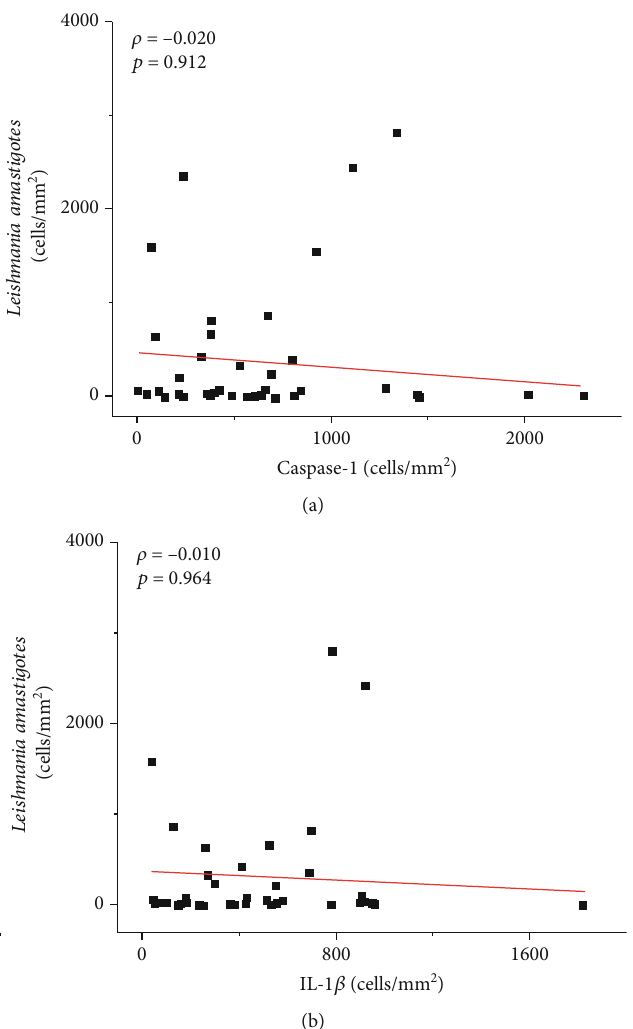
Figure 7: Graphs showing the correlation between the density of Leishmania amastigotes and caspase-1 + cells (a) and IL-1 β + cells (b). The value of ρ is Spearman ’ s correlation coe ffi cient, and p is the p value. The red line indicates a negative